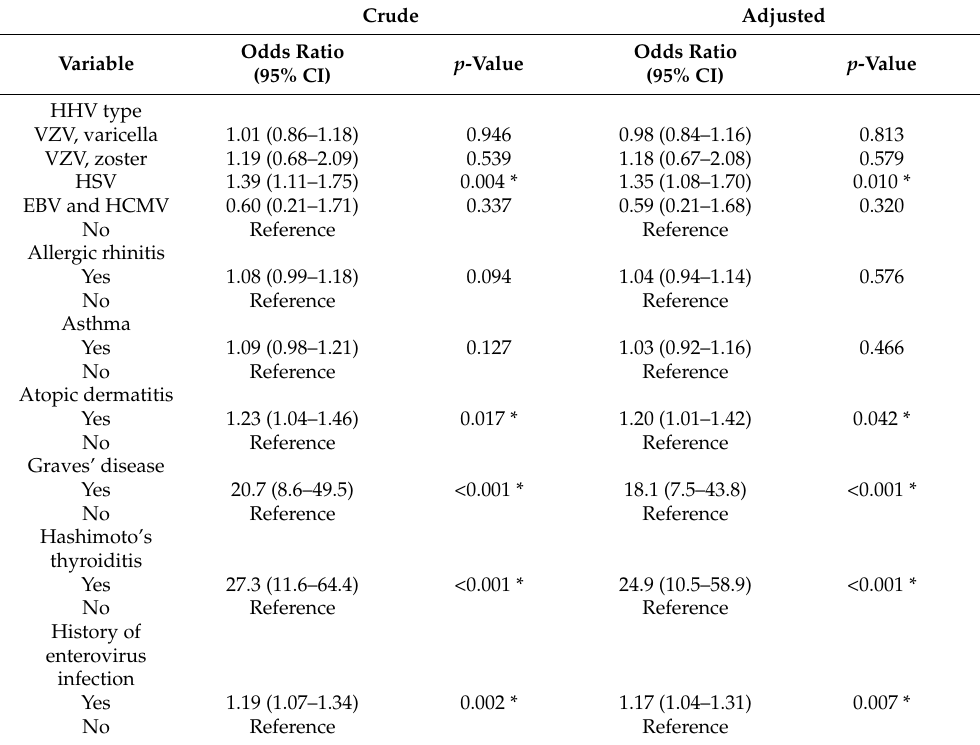
Table 3. Estimating risk of T1DM by multivariable conditional logistic regression model in subjects of age ≤